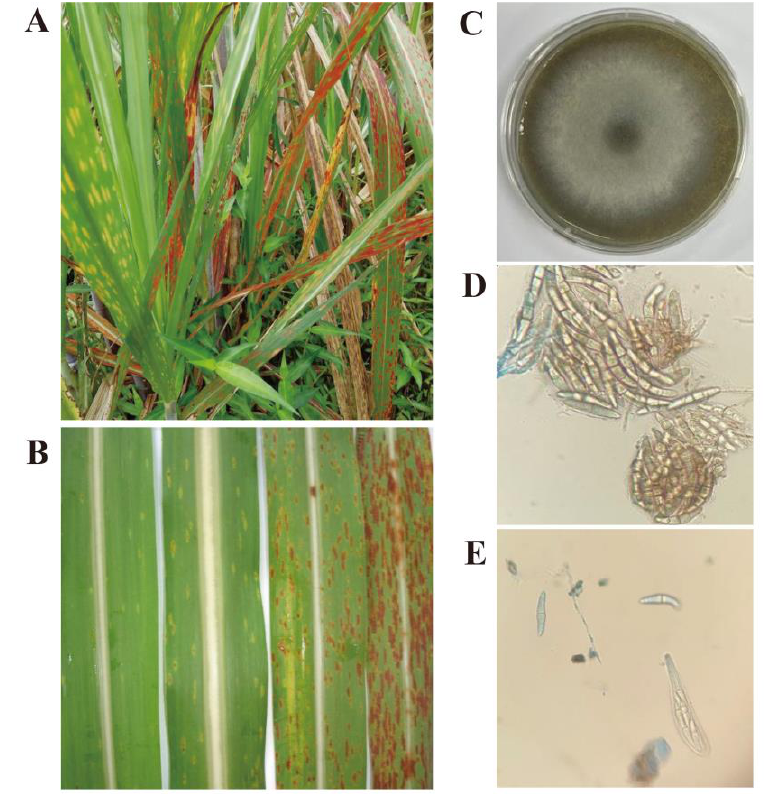
Figure 2. The phenotypic symptoms of sugarcane leaf blight (SLB) on sugarcane cultivar Yuetang93-159 initiated by Stagonospora tainanensis and the morphological characteristics of the strain StFZ01. ( A ) The phenotypic symptoms of SLB on plants. ( B ) Development of the lesions of SLB on leaves. ( C ) The pathogenic colony and mycelia. ( D ) The pathogenic conidia. ( E ) The sexual asci and ascospores.